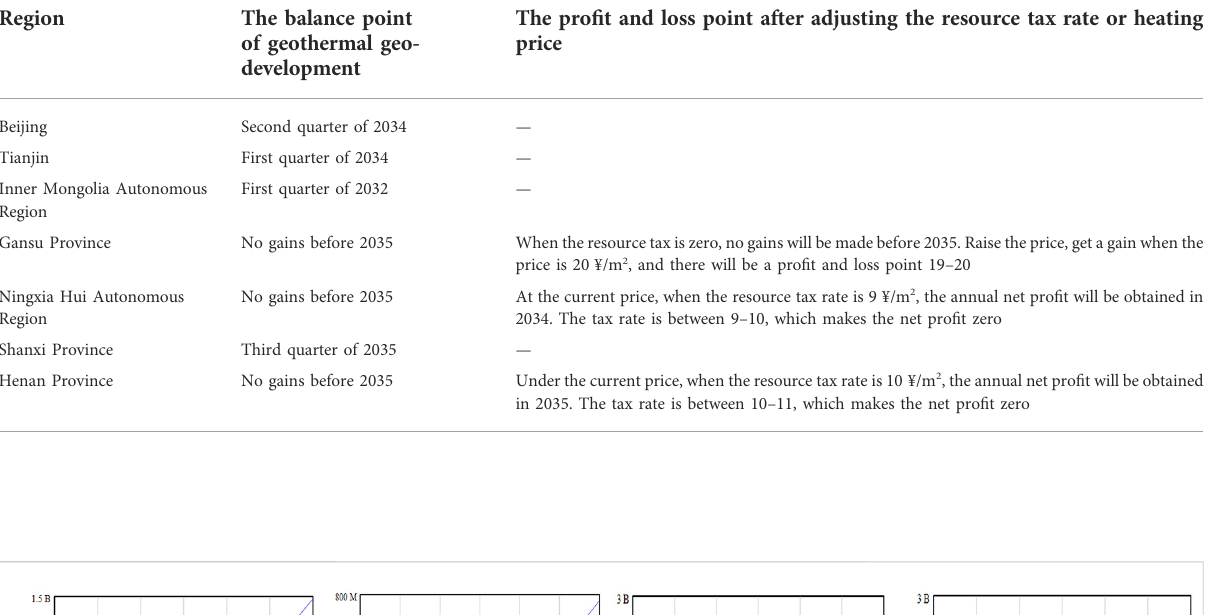
TABLE 6 Heating costs in central heating areas.